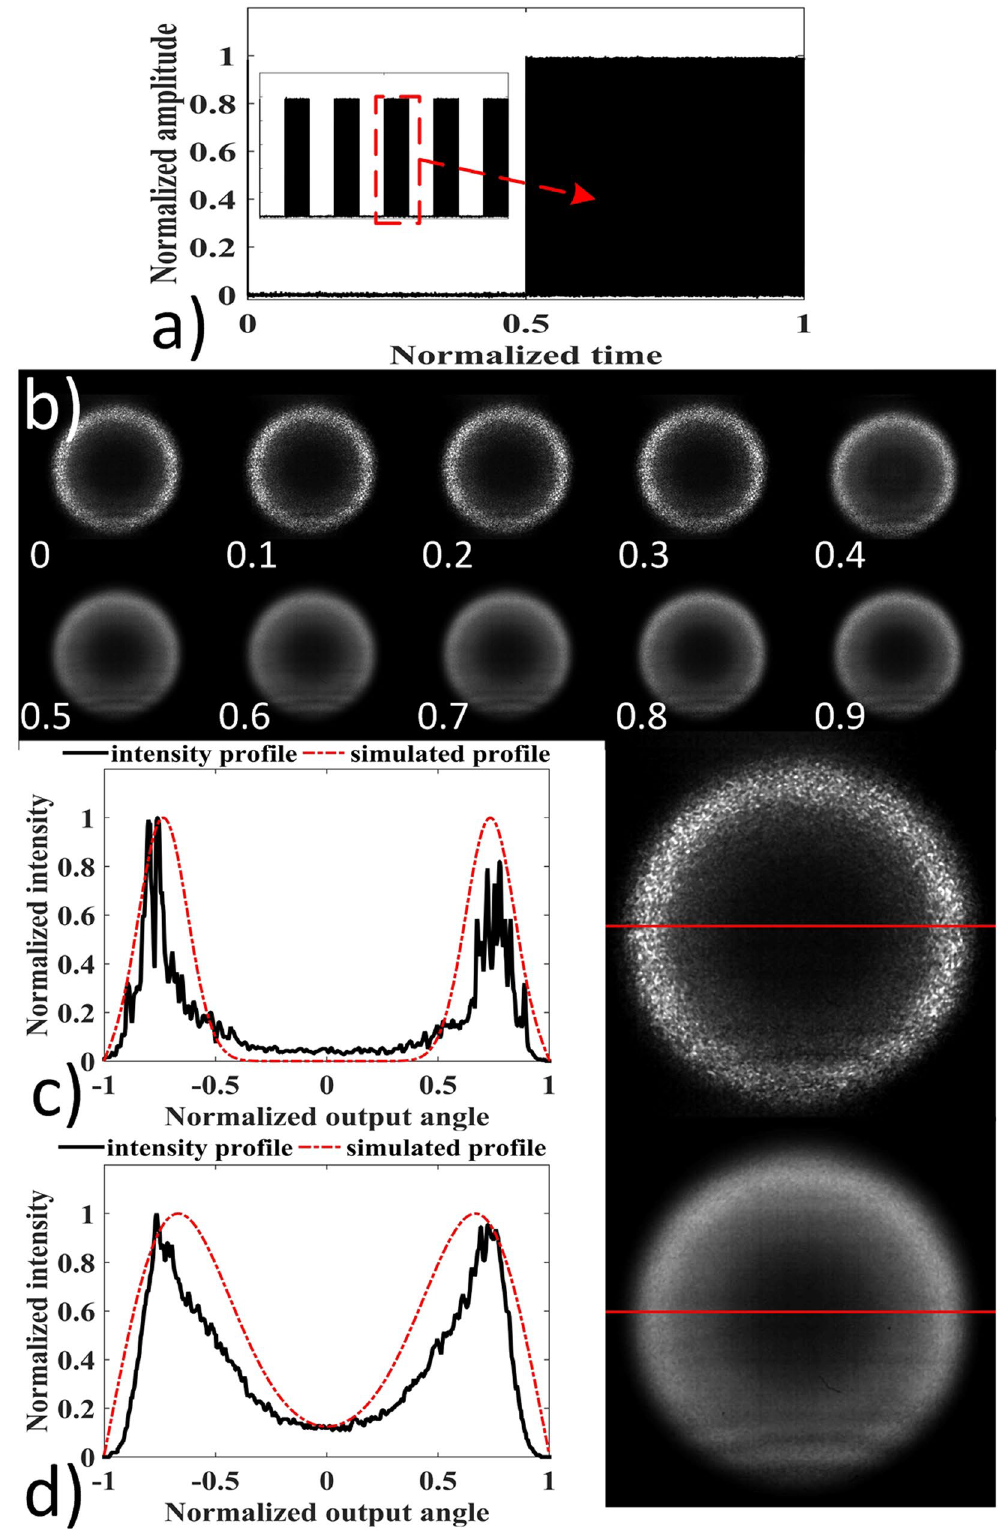
Figure 5. Experimental results of doughnut beam profile tuning through external perturbations. ( a ) 50 Hz and 50% duty cycle square pulse actuated PZT which emitted ultrasonic pulse to perturb the fiber. A series of images captured by the CCD camera operated at 500 Hz during 20 ms corresponding to a period of perturbation are also shown in ( b ). ( c and d ) show the 1 st and 6 th doughnut (0.1 and 0.6), and the intensity profile along the middle row (512 th shown as red line) were also analyzed. The simulated profiles in Fig. 4(b and d) are also shown as red dashed